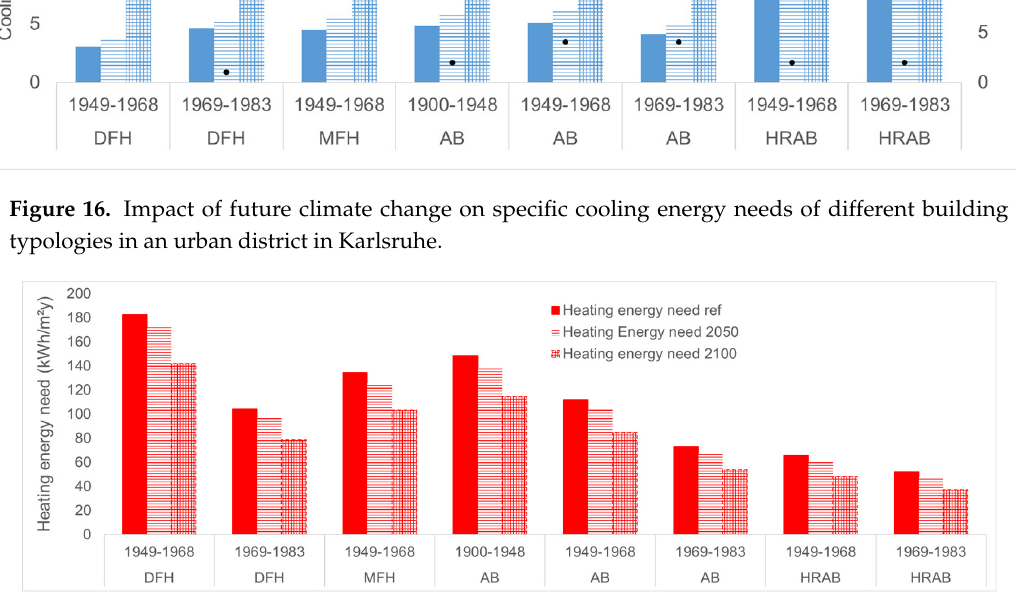
Figure 17. Impact of future climate change on specific heating energy needs of different building typologies in an urban district in Karlsruhe.